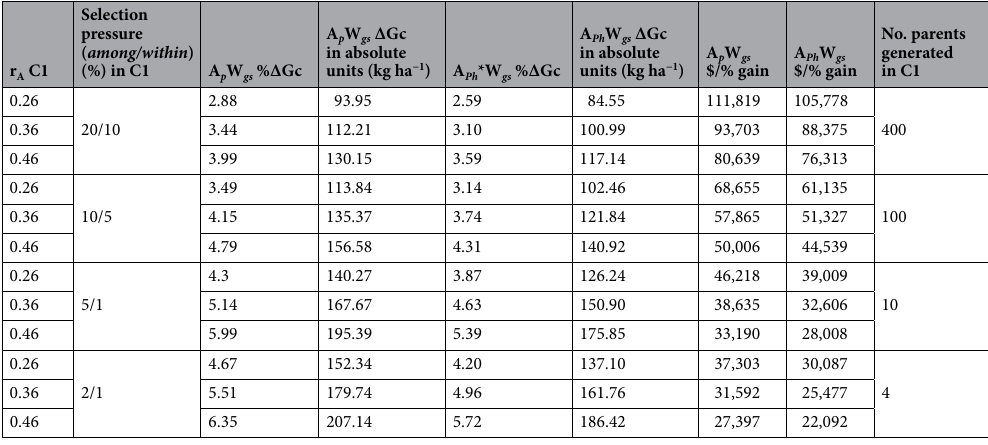
Table 3. Simulation cycle 1 (C1) of selection for seasonal DM yield among 200 HS families of perennial ryegrass based on among HS family phenotypic selection, using data from a 2 year field trial, 3 seasons per year across 2 locations followed by the application of genomic selection (GS) within the selected HS families. Combinations of among and within ( among/within ) HS family selection at different selection pressures (%) and different genomic prediction accuracies (r A ) were applied. The costs per percent genetic gain, relative to the mean BLUP value (3262 kg ha −1 ), of the 200 HS families, based on DM cuts and phenomics ( Ph ) were $7.50 and $0.87 per sample, respectively. For GS, $41 was used as the cost for generating a single GEBV (genomic estimated breeding value). A cycle of selection is the sum of the number of years of the field trial (2 years) plus one extra for progeny generation, total 3 years. Percentage genetic gain per cycle of selection (%ΔGc), cost per percentage of predicted genetic gain ($ per % gain), among Ap family phenotypic selection and within HS gs family genomic selection (A p W gs ) and Ph selection (A Ph W gs ). r A, is the Pearson correlation coefficient between Phenotypic Estimated Breeding Values and Genomic Estimated Breeding Values. $, New Zealand dollars. These results are based on the estimated variance components, from REML analysis of the mock data, used as starting points for simulation of breeding methods. *LiDAR based phenomics accuracy = 0.90.